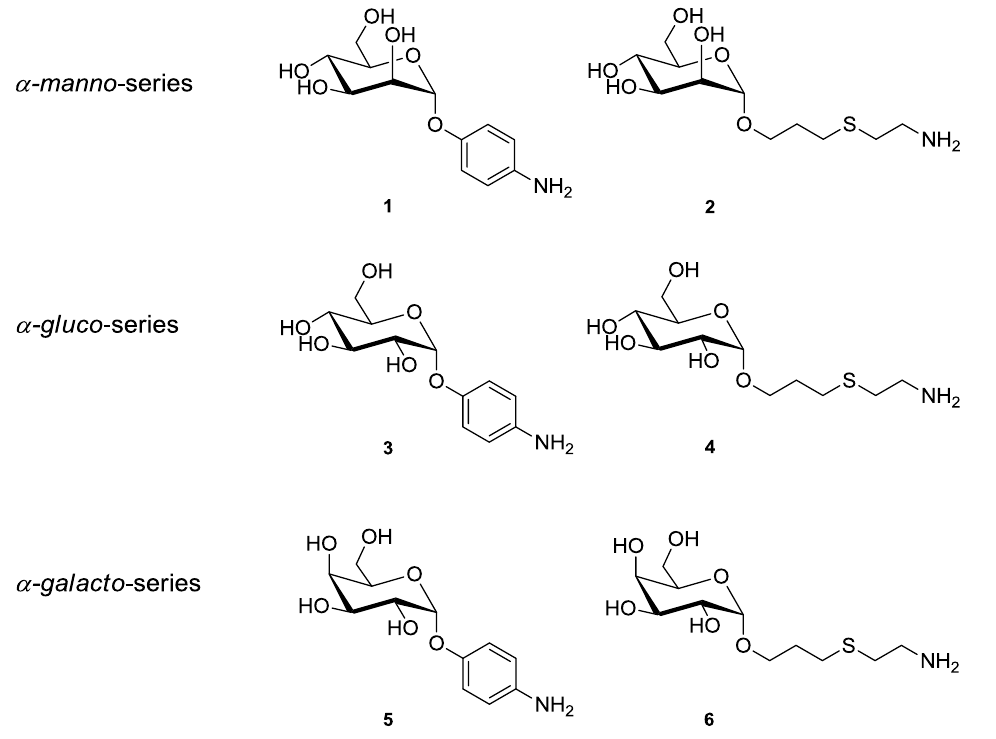
Figure 1. (cid:302) -Glycosides of the manno -, gluco - and galacto -series, employed in the adhesion assays and for glycoarray fabrication.